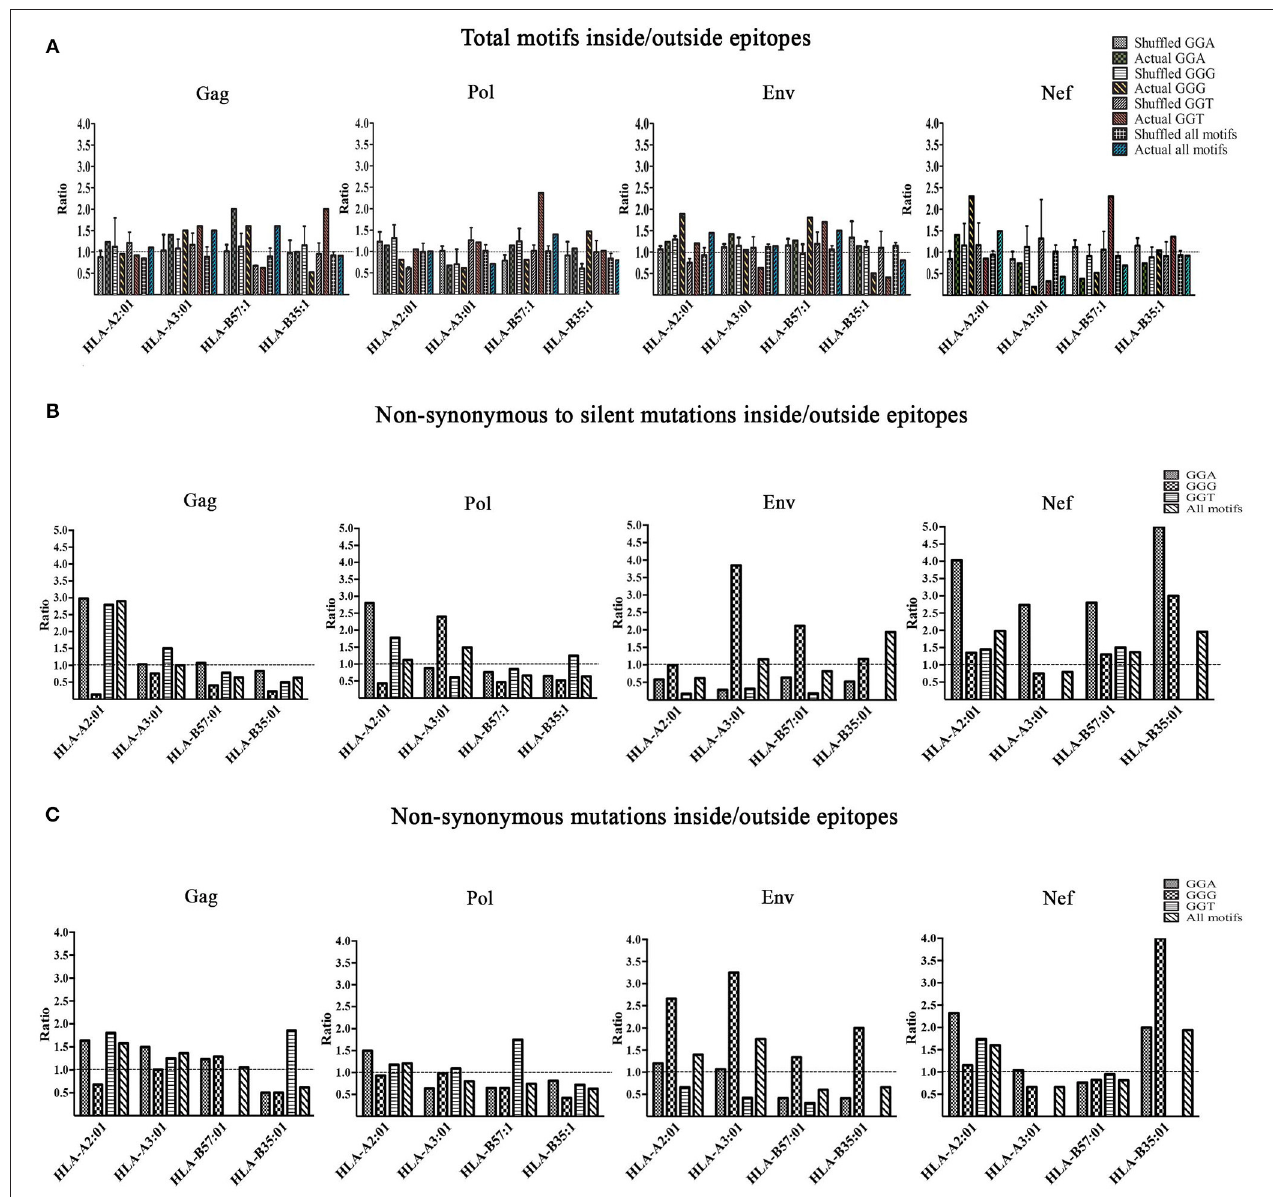
FIGURE 3 | Enrichment of A3G hotspot motifs in CTL-encoding sequences at the nucleotide level and consequences for amino acid substitutions in epitopes. (A) Frequency of A3G hotspot motifs inside vs. outside CTL-epitopes restricted to HLA-A2:01, HLA-A3:01, HLA-B57:01, and HLA-B35:01 in Gag, Pol, Env, and Nef proteins. For Gag, Pol, Env, and Nef genes, the number of A3G hotspots inside vs. outside CTL epitope-encoding sequences were counted. The frequency of A3G hotspots (GGG, GGA and GGT) was then calculated by normalizing to total nucleotide length analyzed, in genomic sequences that either encode (inside) or do not encode (outside) CTL epitopes. Thus, an inside: outside ratio of > 1 indicates enrichment of A3G hotspots in sequences encoding CTL epitopes. As controls for this evaluation, we included parallel sequences in which the HIV genome was randomly shuffled using “Shuffle DNA” (http://www.bioinformatics.org/sms2/shuffle_dna. html) resource 6 independent times. Retaining the same CTL epitope-encoding/non-encoding genomic positions, we repeated the analyses for the shuffled sequences. (B) A3G-induced mutations at the nucleotide level were translated to amino acid sequence changes, for CTL epitopes of Gag, Pol, Env, and Nef restricted to HLA-A2:01, HLA-A3:01, HLA-B57:01, and HLA-B35:01. We counted the number of non-synonymous substitutions as well as silent consequences within and outside CTL epitopes and normalized for total amino acid protein length, followed by calculating a ratio to measure whether A3G-driven non-synonymous substitutions are more frequent than silent ones within vs. outside CTL epitopes. (C) A ratio of non-synonymous substitutions inside vs. outside CTL-epitopes restricted to HLA-A2:01, HLA-A3:01, HLA-B57:01, and HLA-B35:01 in Gag, Pol, Env, and Nef